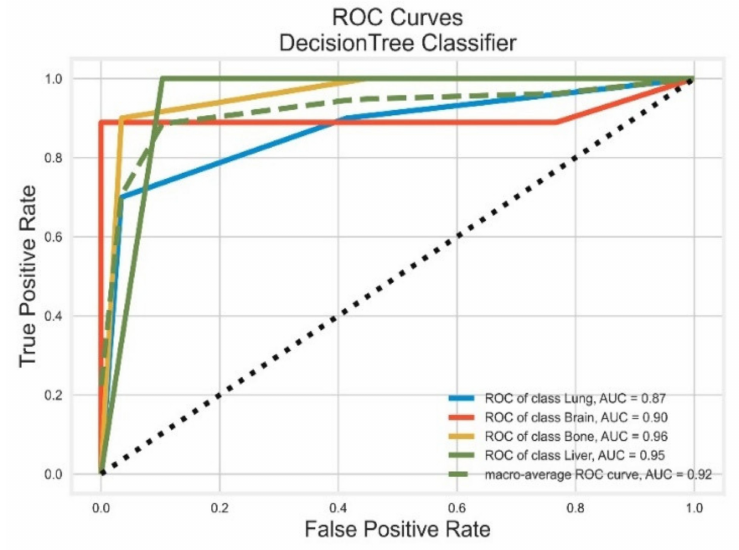
Figure 16. ROC Curves (Decision Tree